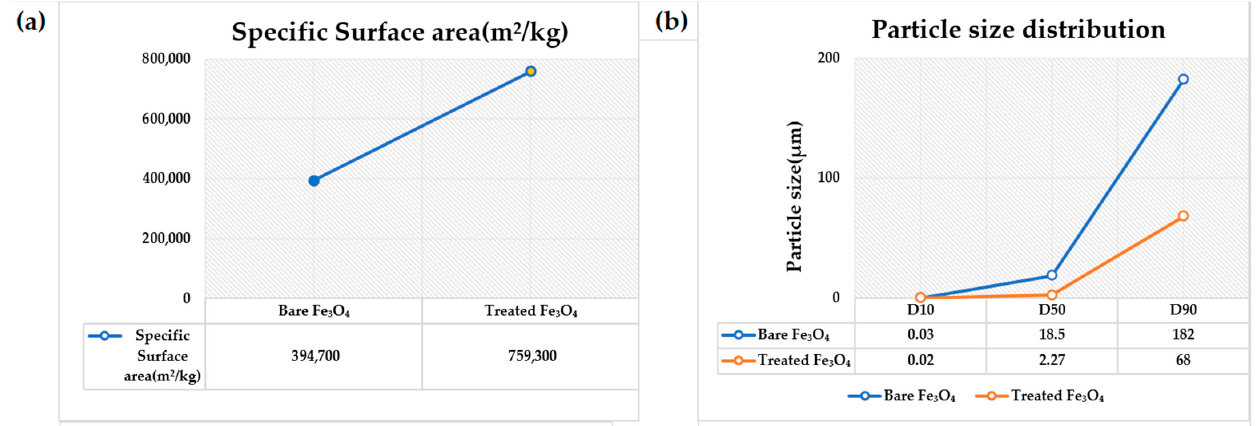
Figure 8. ( a ) Specific surface area, ( b ) Particle size distribution plot of bare Fe 3 O 4 and SHMP-treated Fe 3 O 4